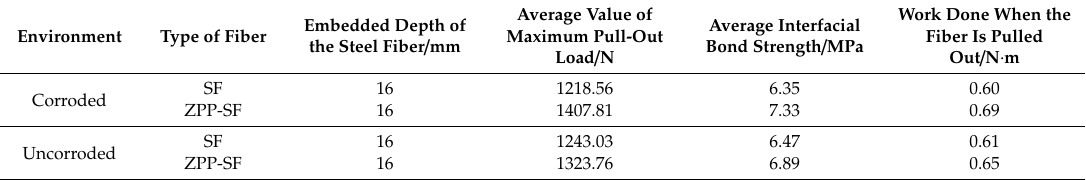
Table 4. Bond strength of the interface between the steel fiber and concrete matrix.